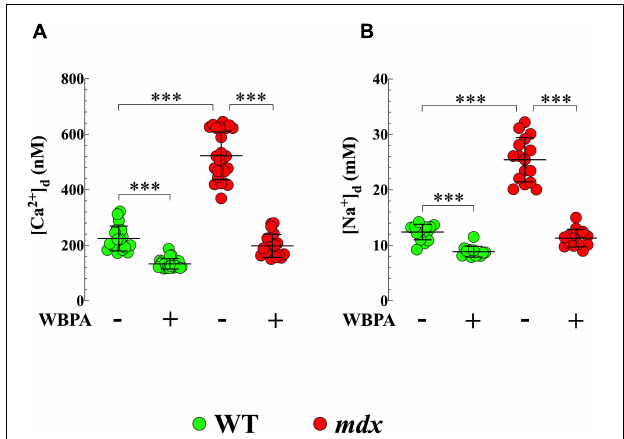
FIGURE 1 | Whole body periodic acceleration lowered [Ca 2 + ] d and [Na + ] d in cardiomyocytes. [Ca 2 + ] d and [Na + ] d was measured in cardiomyocytes from 15-month treated and untreated, WT and mdx mice using ion-specific microelectrodes. Diastolic [Ca 2 + ] (A) and [Na + ] (B) were significantly higher in mdx than WT cardiomyocytes (2.4-fold and 2-fold, respectively). Whole body periodic acceleration (WBPA) reduced [Ca 2 + ] d by 2.6-fold in mdx cardiomyocytes and by 1.7-fold in WT cardiomyocytes (A) , while that [Na + ] d was reduced by 2.2-fold in mdx cardiomyocytes and by 1.4-fold in WT cardiomyocytes (B) . [Ca 2 + ] d measurements: Untreated and WBPA-treated WT, N = 3 mice per experimental condition , n = 19–21, respectively; Untreated and WBPA-treated mdx N = 4 mice, n = 25–19, respectively. [Na + ] d measurements: Untreated and WBPA-treated WT, N = 3 mice per experimental conditions , n = 15–12, respectively; Untreated and WBPA-treated mdx N = 3 per experimental condition, n = 16–14, respectively. Values are expressed as means ± S.D. One-way ANOVA with Tukey’s post-test, *** p ≤